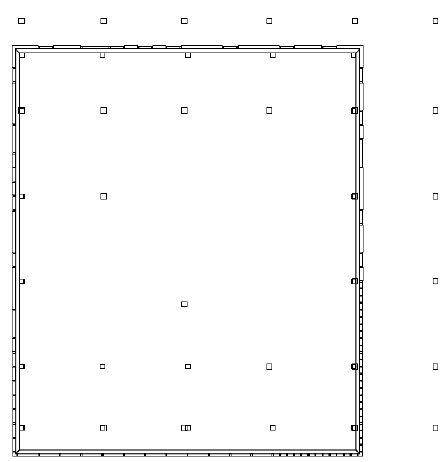
Figure 2. Plans of building A: ( a ) ground floor; ( b ) first floor.